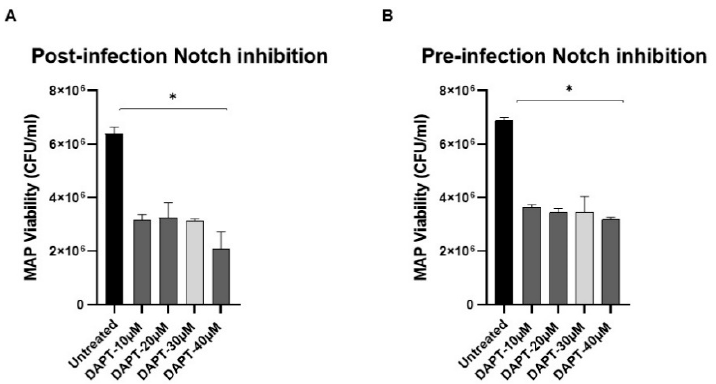
Figure 3. E ff ect of DAPT on MAP viability. ( A ): MAP viability was measured in THP-1-derived macrophage infected with MAP (UCF 4, 10 7 CFU / mL) followed by DAPT (0–40 µ M) treatment. ( B ): MAP viability was measured in THP-1-derived macrophages pre-treated with DAPT (0–40 µ M) followed by MAP infection (UCF 4, 10 7 CFU / mL) . MAP viability was measured using Live / Dead ™ Bac light ™ bacterial viability assay. All experiments were performed in triplets. Data are shown as mean ± SD, and significance is considered as * p < 0.05.